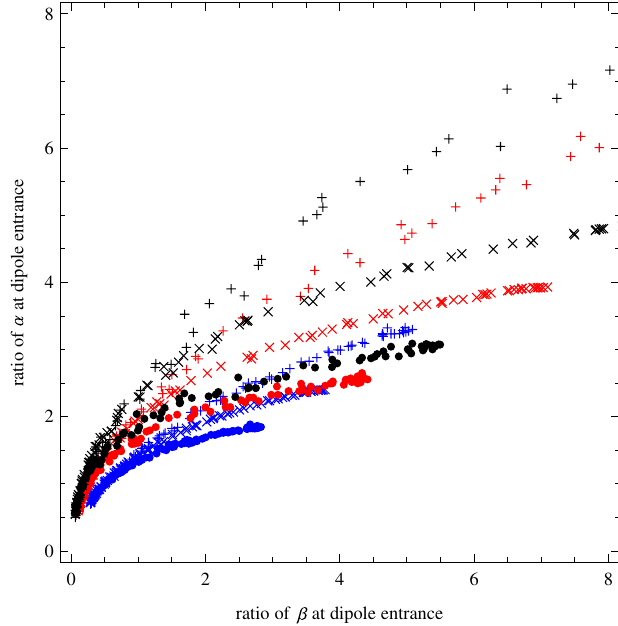
FIG. 14. Relative changes in initial (cid:8) and (cid:7) functions at the dipole entrance for the optimal solutions. Lattices are marked by AME ( (cid:2) ), TME ( þ ), and EME ( (cid:7) ). Peak-field strength factors are 2 (blue), 4 (red), and 6 (black).